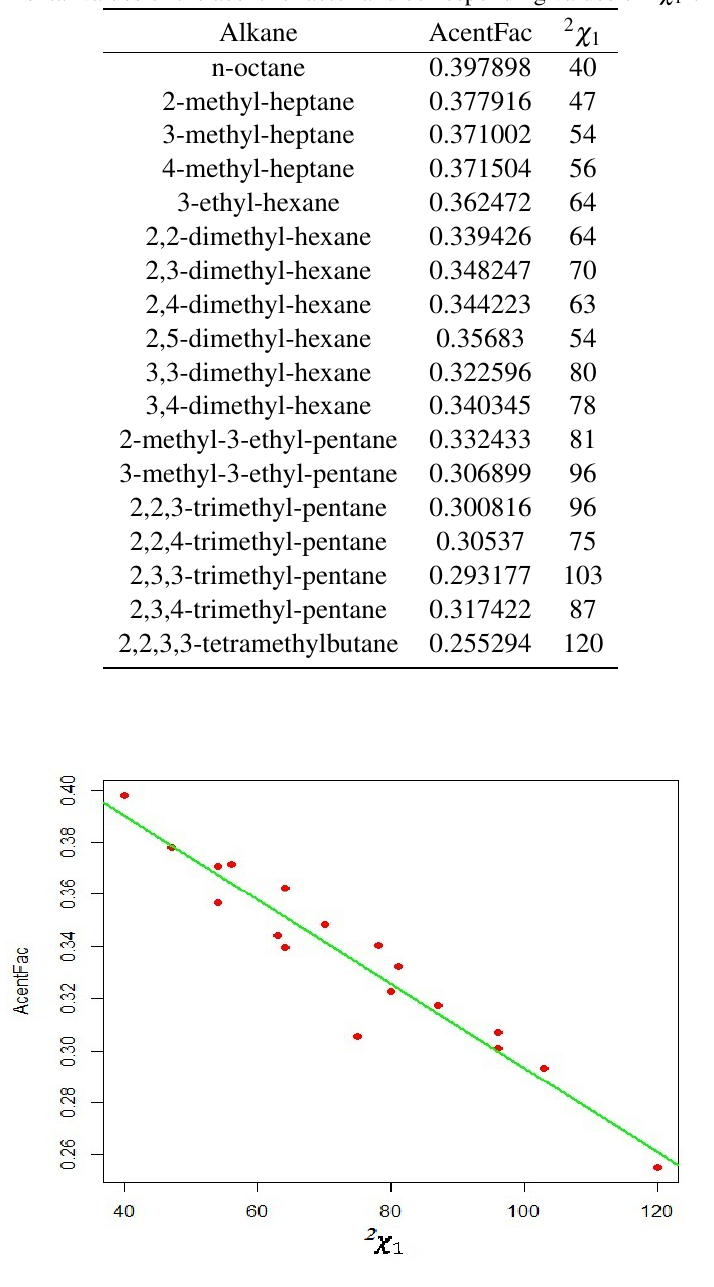
Table 1 Experimental values of the acentric factor and corresponding values of 2 χ 1 of octane isomers.